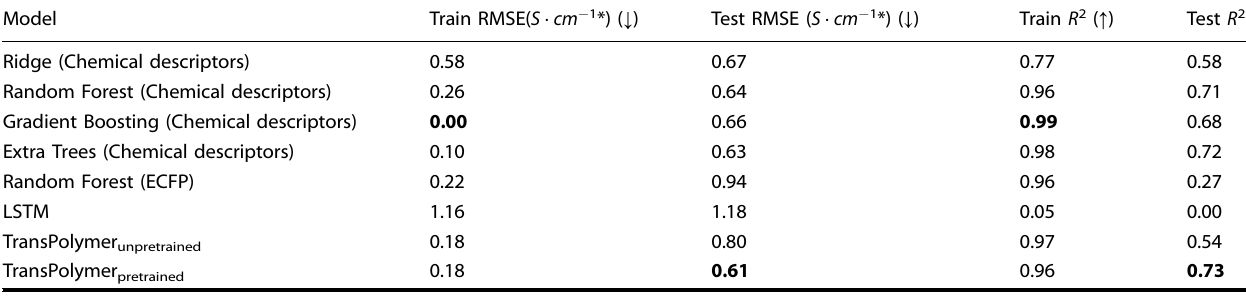
Table 3. Performance of TransPolymer and baseline models on PE-II. Model